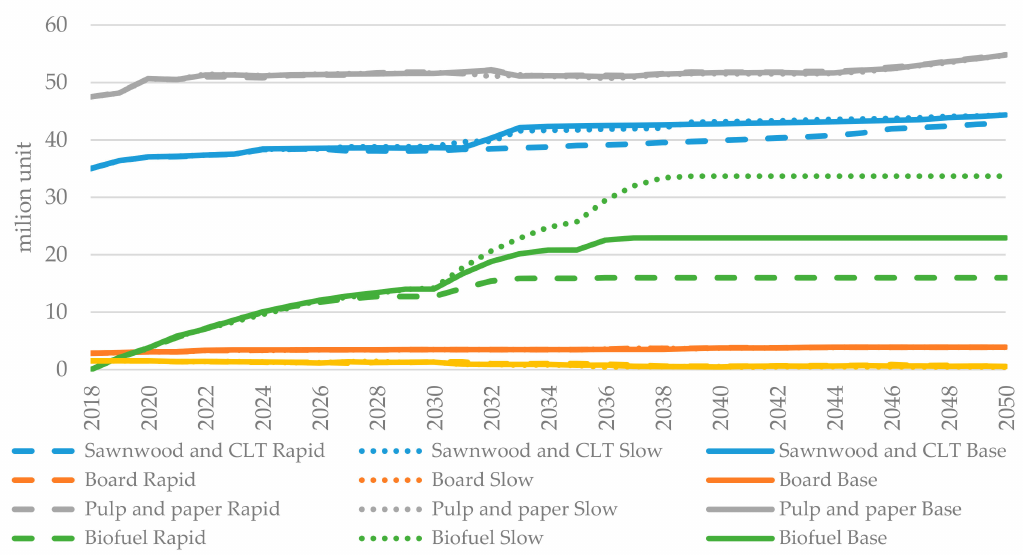
Figure 12. Modelled production of the main industrial products in the Nordic countries for the base, rapid electrification and slow electrification